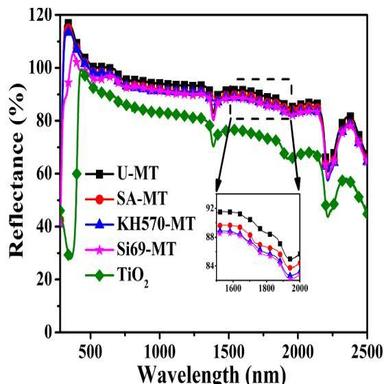
UVPC curves of TiO2, untreated and modified MT particles.